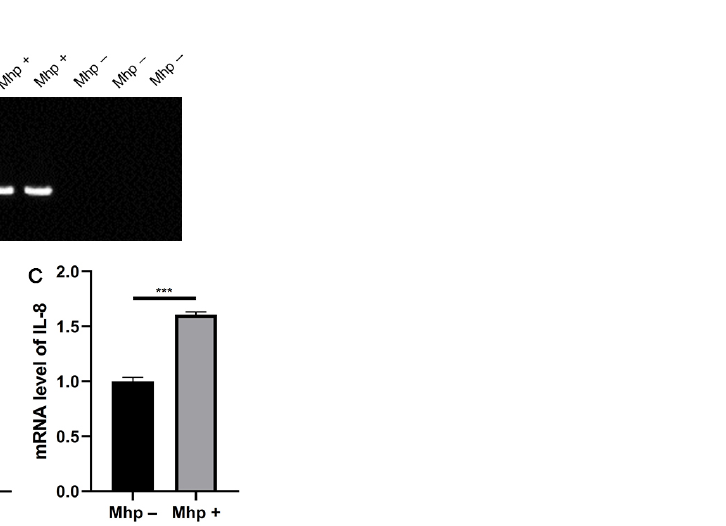
Figure 1. PCR identification of pig alveolar macrophage (PAM) 3D4/21 cells infected with M. hyopneumoniae and the mRNA expression of IL-6 and IL-8 . ( A ) PCR identification of PAM 3D4/21 cells infected with M. hyopneumoniae . ( B ) IL-6 and ( C ) IL-8 mRNA expression after M. hyopneumoniae infection. The data are presented as the mean ± SD. The experiment was repeated three independent times. *** p < 0.001 compared to the uninfected group.